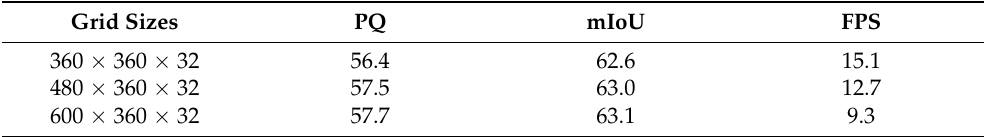
Table 5. Ablation study of the proposed approach with different grid sizes on the validation split of SemanticKITTI. Metrics are provided in [%], and FPS is in